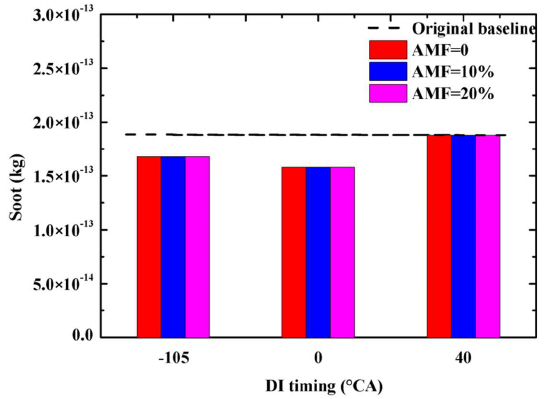
Figure 14. Soot variation at different DI timings and AMF values.